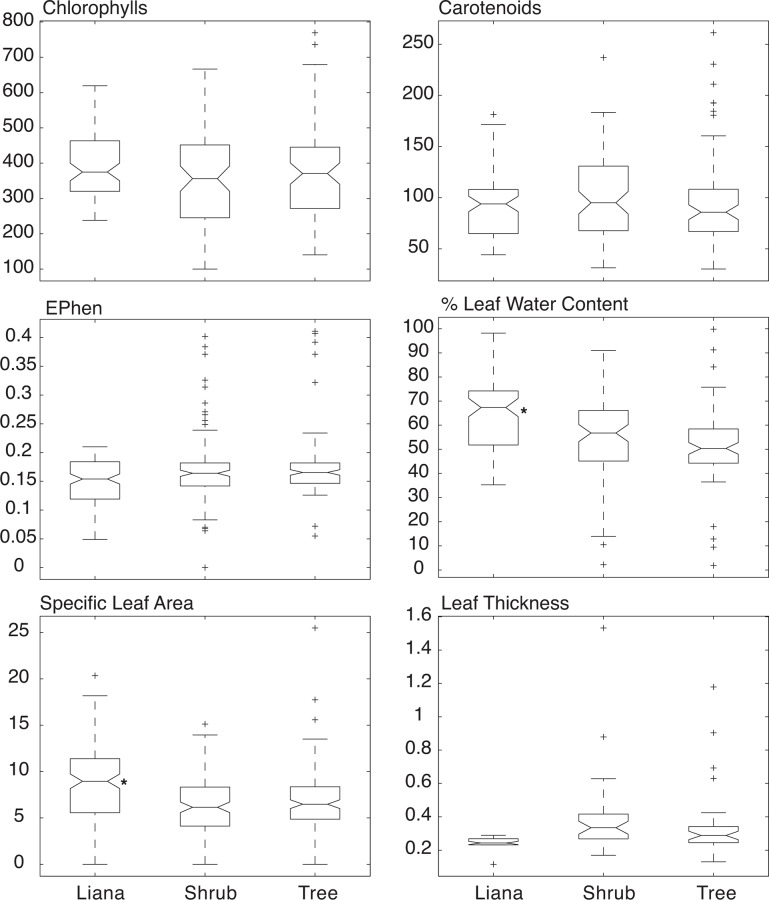
Comparison of leaf trait distributions between vegetation life forms by one-way ANOVAs.Means that significantly differ (p<0.01) are denoted with an asterisk. CHL = Total Chlorophylls A + B (mol), Car = Carotenoids (mol), EPhen = Polyphenol content,%H2O = Percentage. Leaf Water Conent, SLA = Specific Leaf Area (m2 kg-1), LeafThick = Leaf thickness (mm).